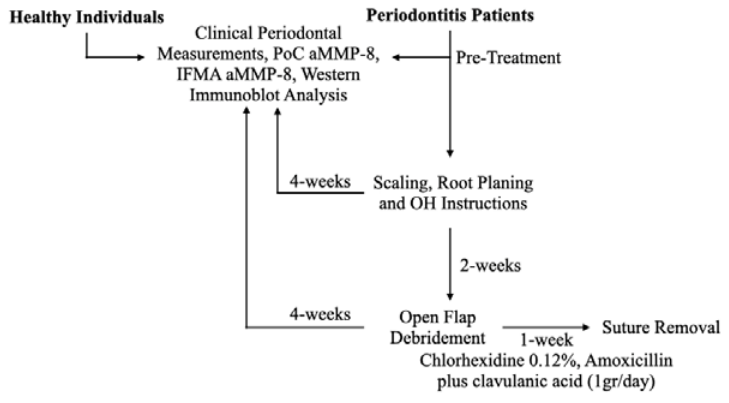
Figure 1. Study Figure 1. Study design.